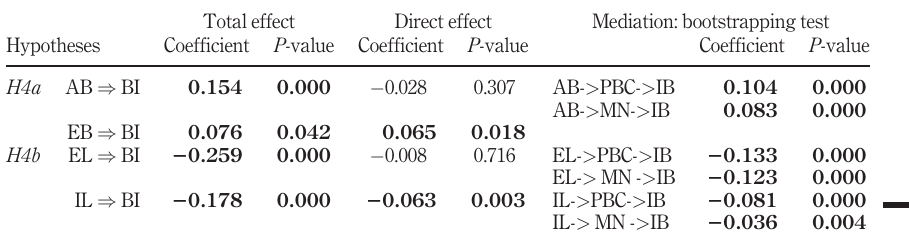
Table 3. Mediation analysis